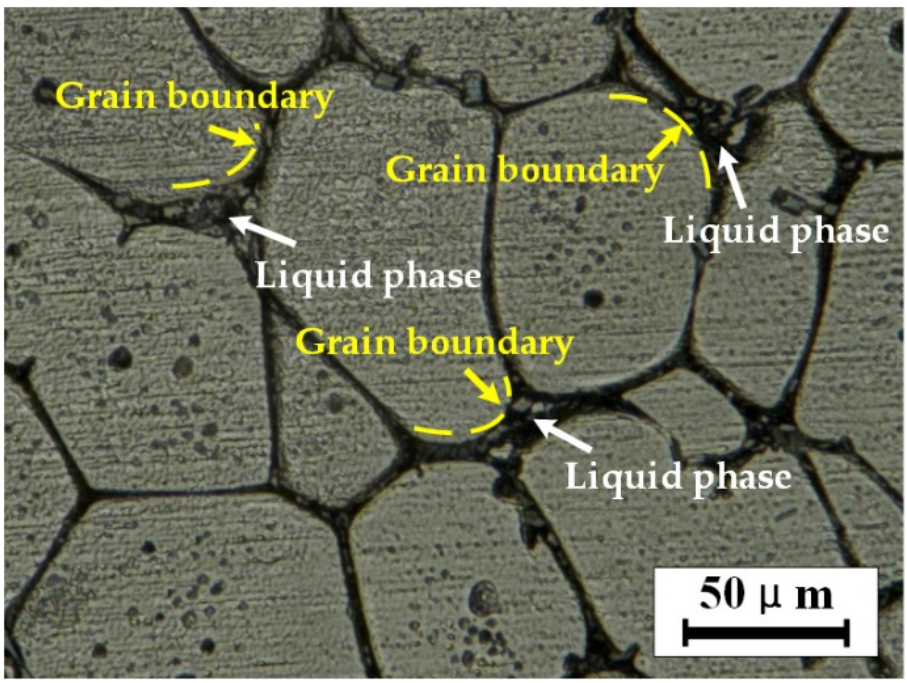
Figure 9. The high radius of curvature component is preferentially melting.